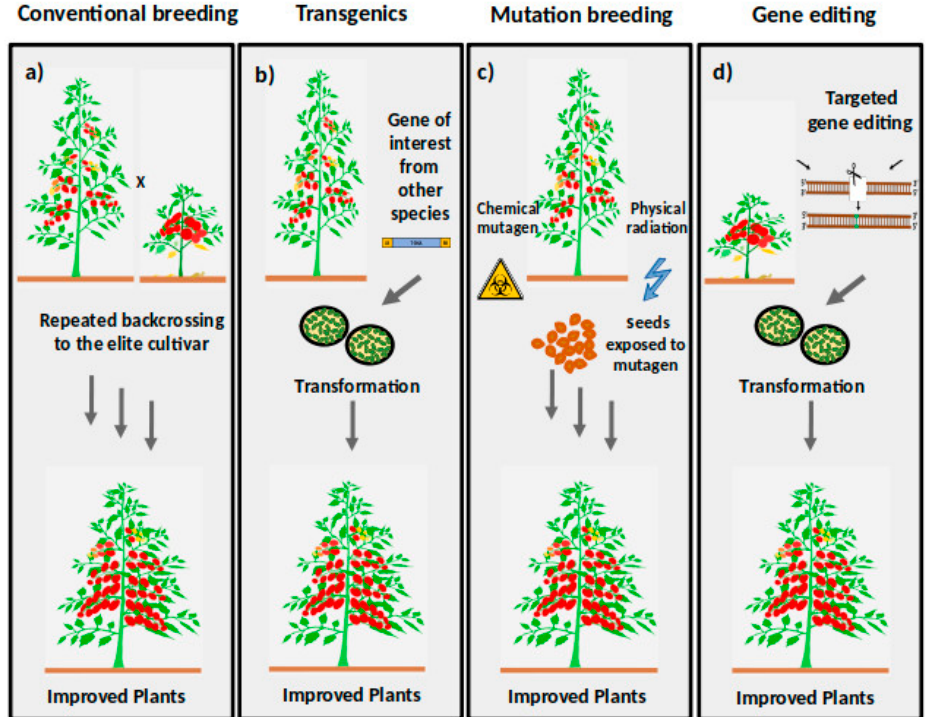
Figure 2. Represents the breeding techniques employed for crop improvement. ( a ) Conventional breeding involves selective breeding of two tomato species with desired traits. For example, a tall plant with low yield and stress tolerance is crossed to a small plant with bigger fruits. Repeated backcrossing is performed to the elite cultivar to generate plants with desired traits. Conventional breeding is mostly accompanied with loss of genetic diversity due tote selection process. ( b ) Transgenic breeding involves the introduction of a desired gene (transgene) from other species into the selected plant by the transformation process. ( c ) Mutation breeding involves physical radiation or a chemical mutagen to induce mutations. The mutated populations (M 1 ) are generated, and to reduce chimerism M 2 or higher populations are produced. The mutant is then screened either by forward or reverse genetics. ( d ) Targeted genome editing (detailed described in Section 2.7), schematic describes the procedure for generating a wide variety of improved plant traits. After generation of edited plants are then screened phenotypic and genotypic for discovering the plant with desirable traits.